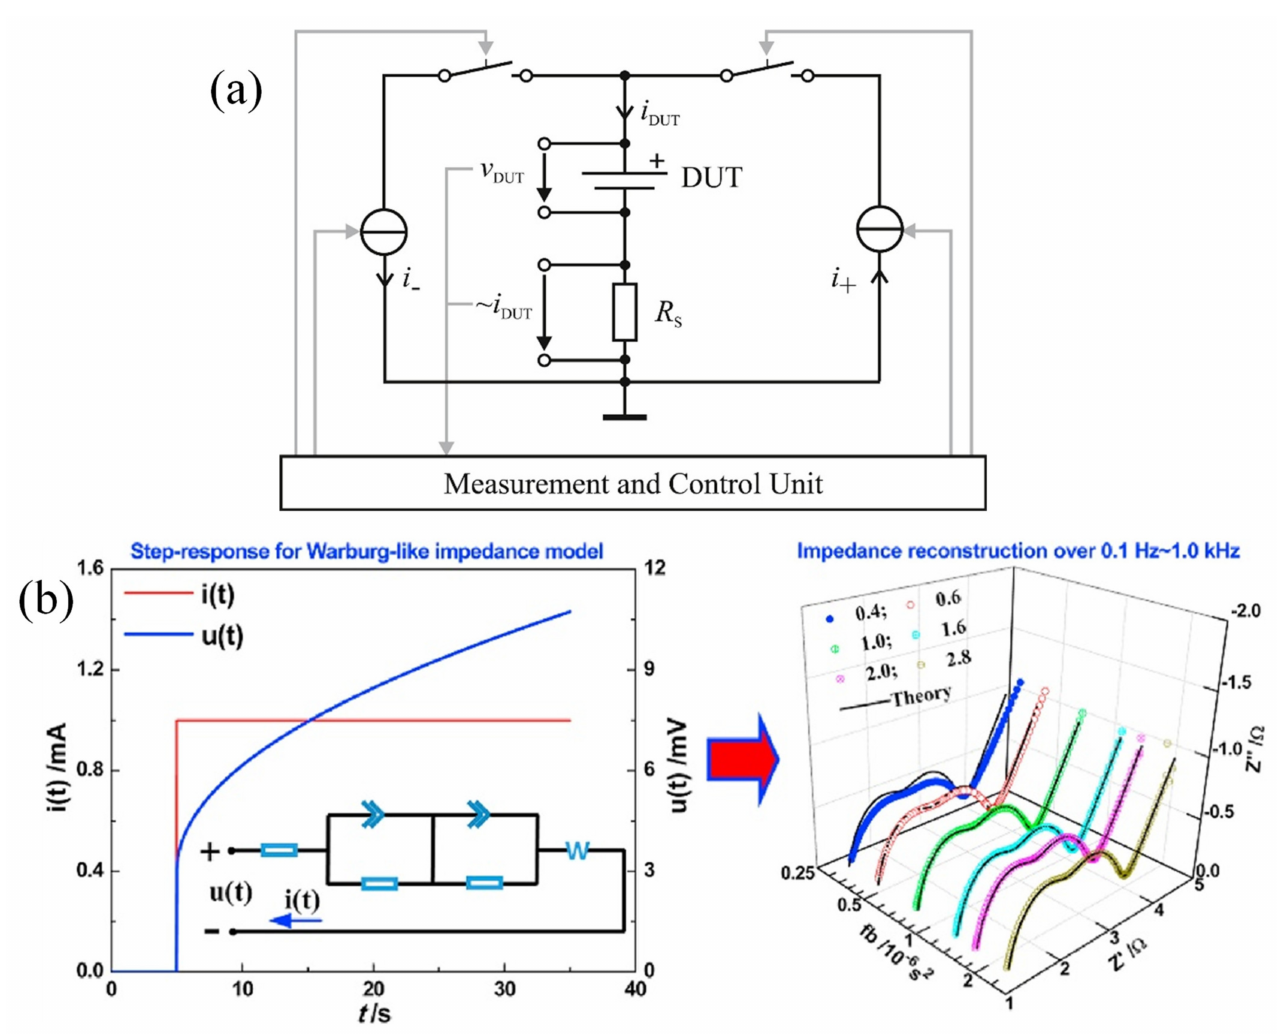
Figure 2. ( a ) Basic structure of the new single-cell tester. The DUT is charged and discharged by two controlled current sources. Current measurement is achieved with a shunt resistor RS. Reprinted with permission from Ref. [19]. Copyright 2014, Elsevier B.V. ( b ) Equivalent circuit model and corresponding impedance spectrum. Reprinted with permission from Ref. [32]. Copyright